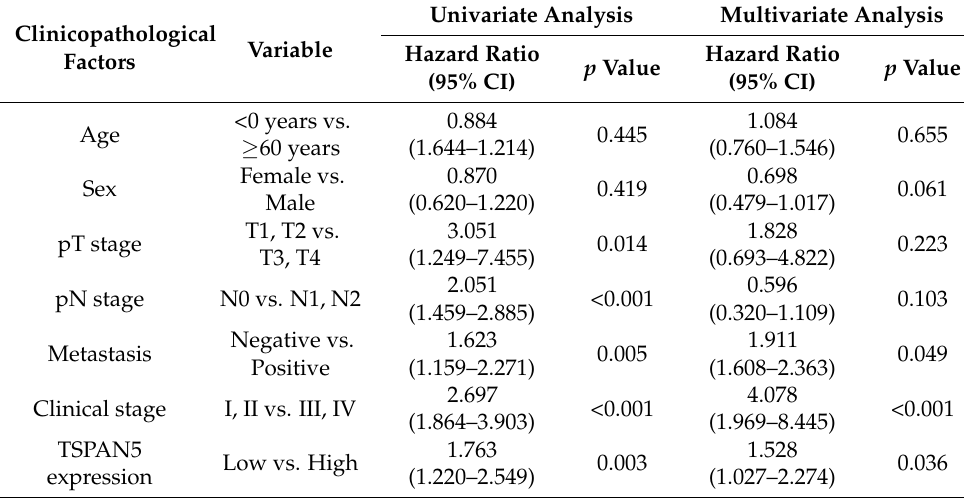
Table 2. Univariate and multivariate Cox regression models.